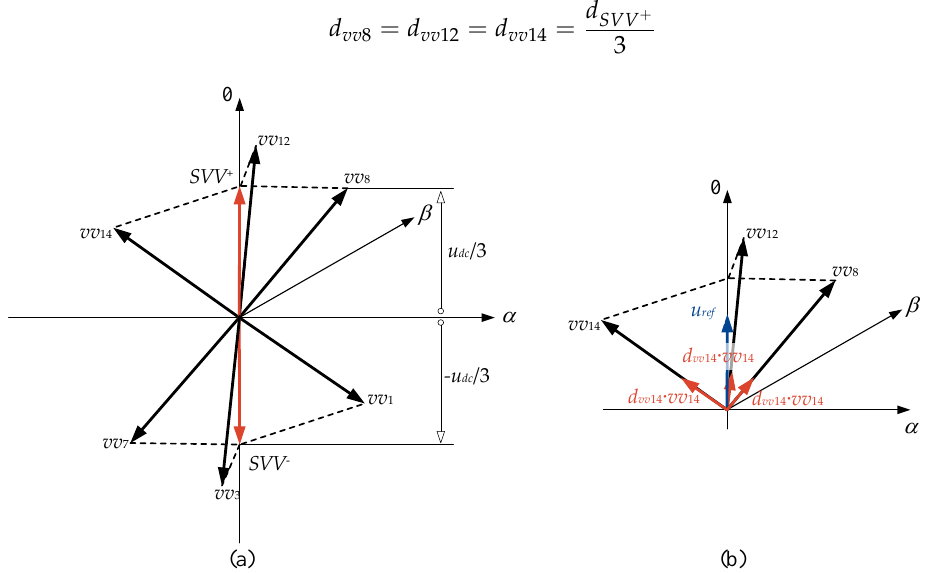
Figure 10. Space vector modulation in zero-sequence subspace: ( a ) synthetic voltage vectors; ( b ) modulation with SVV + .